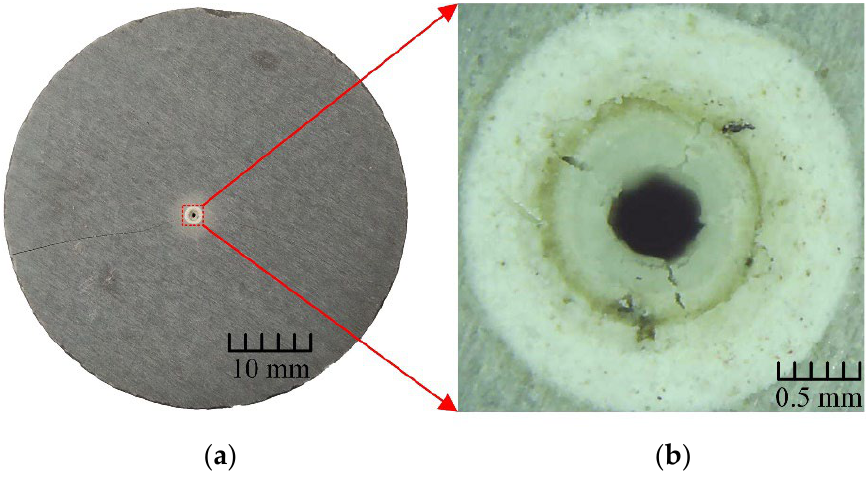
Figure 7. ( a ) Image of rock surface; ( b ) Magnified view of the small hole.